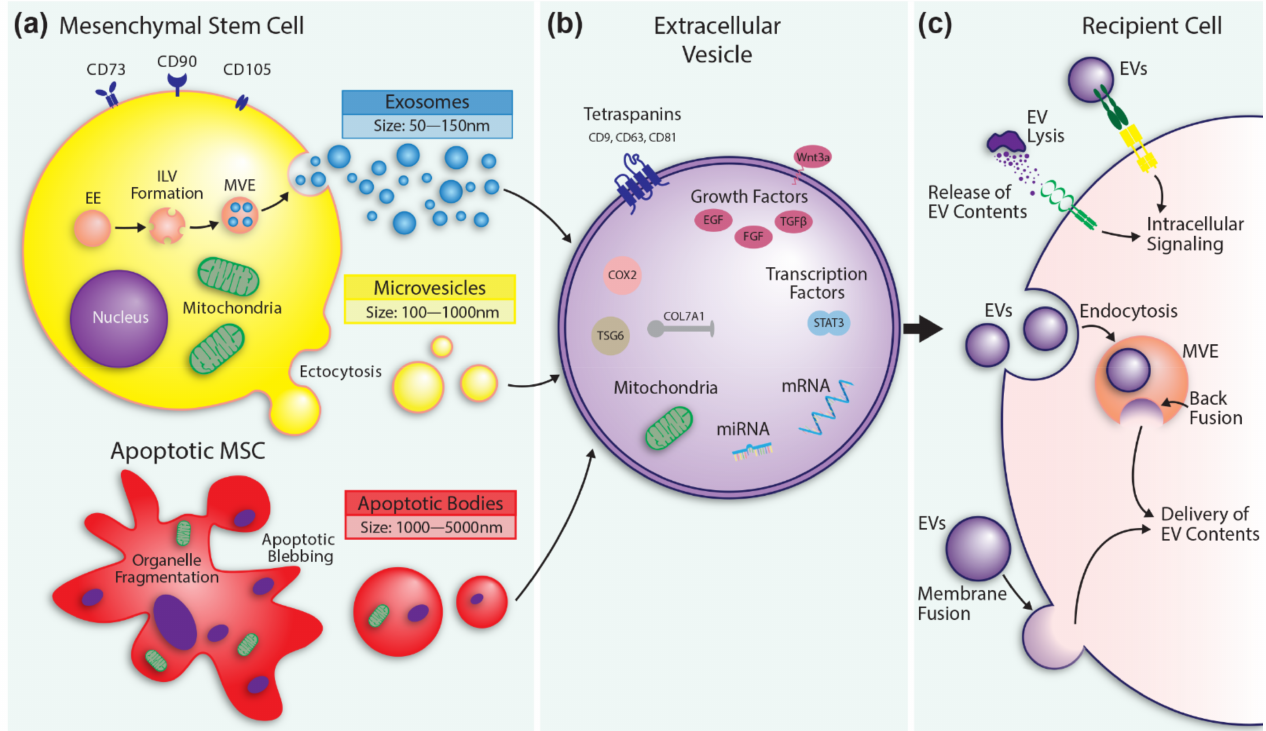
Figure 1. Mesenchymal stem cell (MSC) extracellular vesicle (EV) formation and messaging. ( a ) Exosome formation begins with membrane endocytosis of the early endosome (EE) to form intraluminal vesicles (ILV). ILVs are contained within a multivesicular endosome (MVE). Exosomes are released following fusion of the MVE with the plasma membrane. Microvesicles are released by ectocytosis and budding from the plasma membrane. Apoptotic bodies form from cells undergoing apoptosis and may contain fragmented organelles. ( b ) Depiction of select EV contents that contribute to wound healing. Additional EV contents are discussed in the main text and Table 1. ( c ) Released EVs interact with a recipient cell through membrane receptors thereby initiating intracellular signaling. EVs can also deliver their cargo to the recipient cell following endocytosis and back fusion within an MVE or by direct fusion with the plasma membrane. Lysis of EVs in the extracellular space releases contents that then act on the recipient